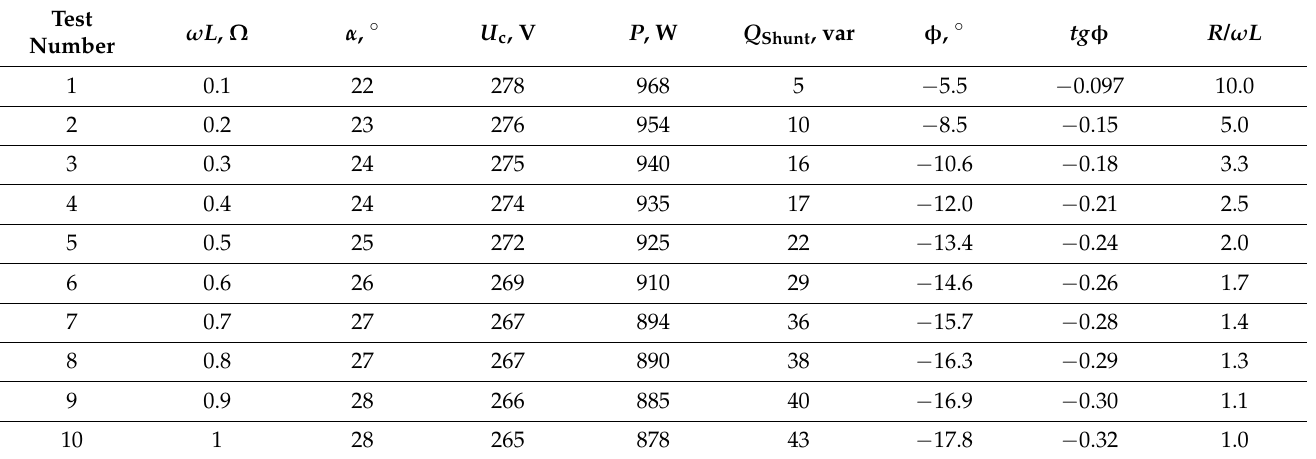
Table 1. Electrical parameters at the point of connection of the VFD to the PDL and their dependence on the internal R / ω L ratio of the